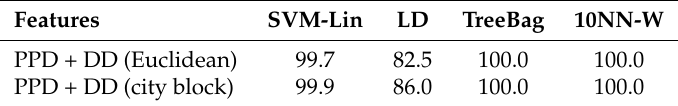
Table 2. Results of 10-fold cross-validation obtained for Dataset 1.